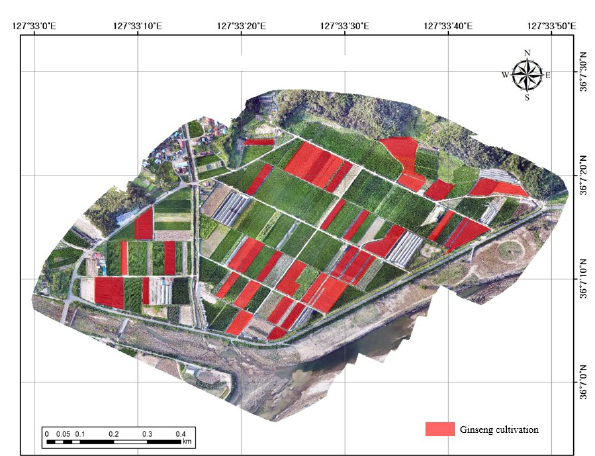
Figure 5 . Damage analysis in ginseng cultivation field